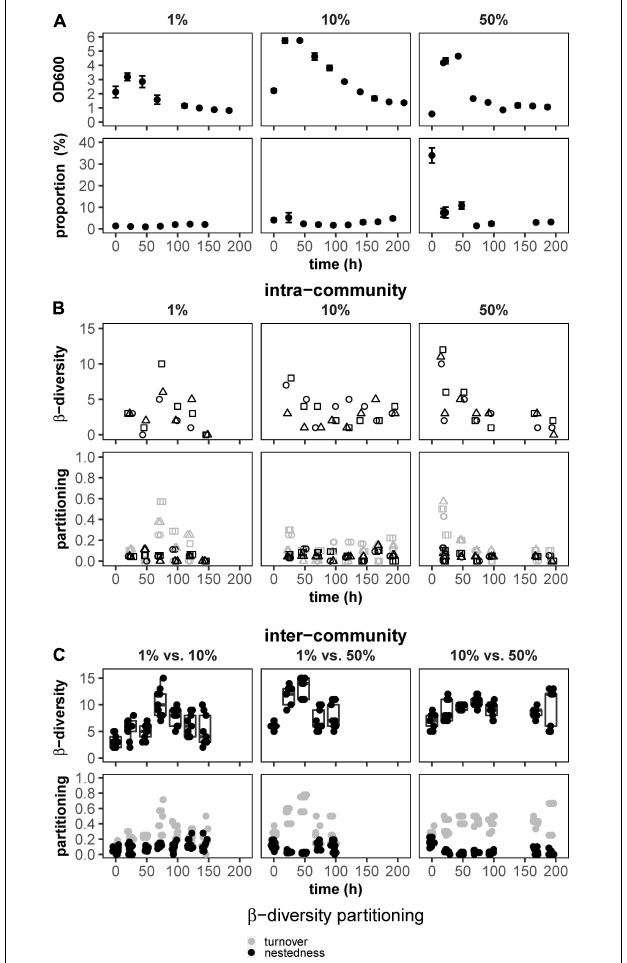
FIGURE 1 | Growth and ecological characteristics of nine batch-cultured WWC co-cultures augmented by proportions of gfp -labeled P. putida KT2440 (1, 10, and 50%; left to right). (A) Top: OD changes over 192 h, (A) bottom: changes of proportions of gfp -labeled P. putida KT2440 within the WWCs. (B) Top: variation in intracommunity β -diversity values between successive time points over 192 h. (B) Bottom: partitioning of intracommunity β -diversity into turnover and nestedness components between successive time points over 192 h. (C) Top: intercommunity β -diversity between pairs of WWCs per co-culture setup. (C) Bottom: partitioning of intercommunity β -diversity into turnover and nestedness components over 192 h. All cultivations were done in